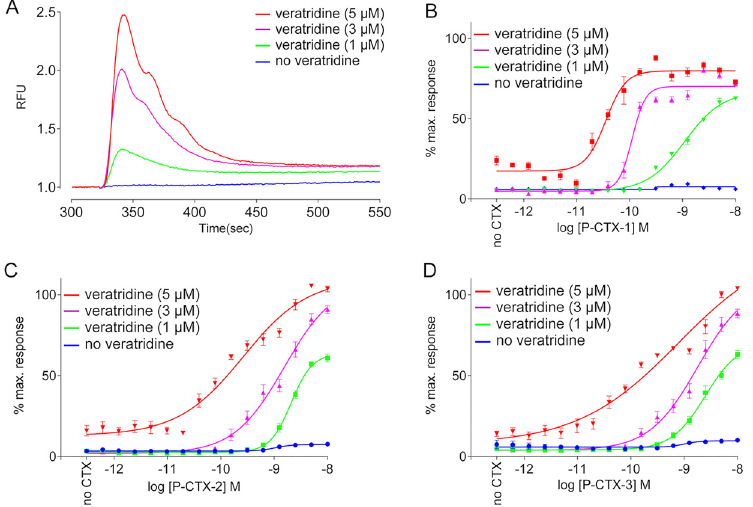
Fig 1. Synergistic effects of P-CTX-1, 2, 3 on veratridine responses in SH-SY5Y cells. (A) Representative veratridine-induced responses in SH-SY5Y cells pre-incubated for 300 s with 0.5 nM